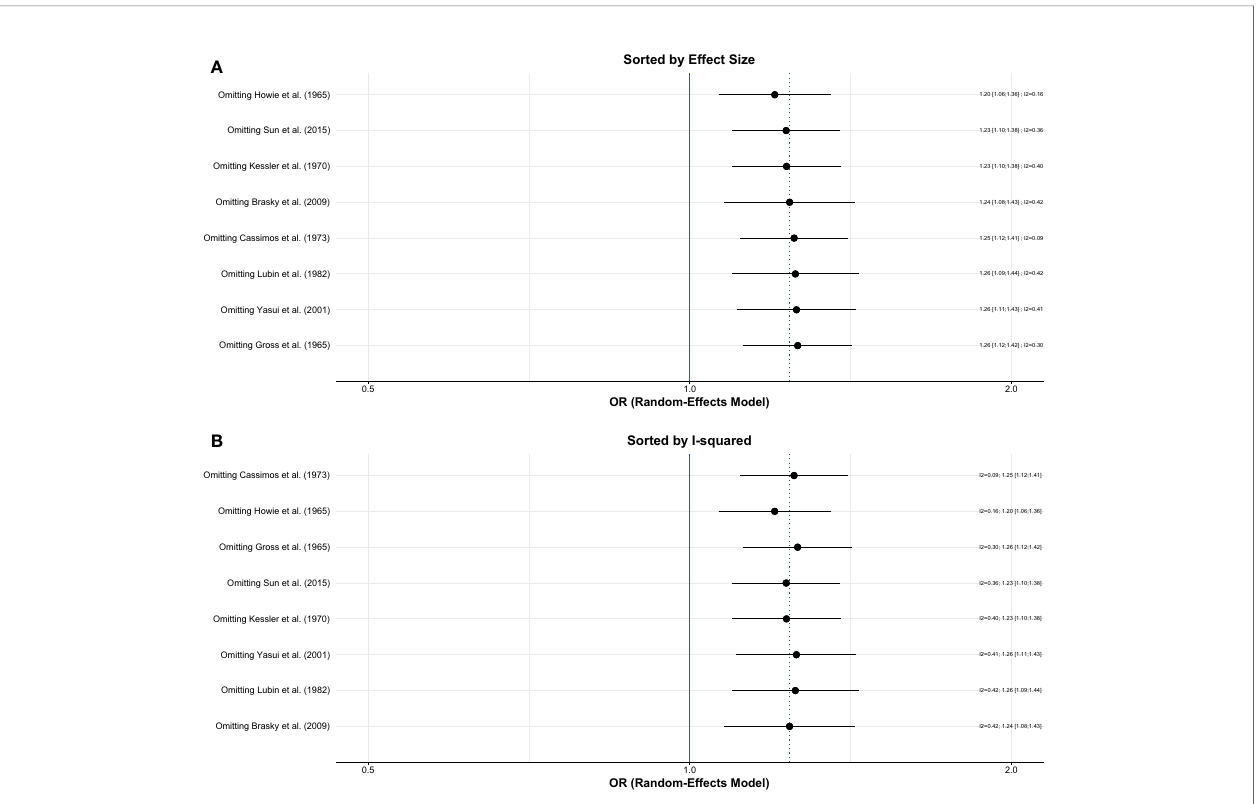
FIGURE 3 | In fl uence (leave-one out sensitivity) analysis; (A) Sorted by effect size (B) Sorted by I